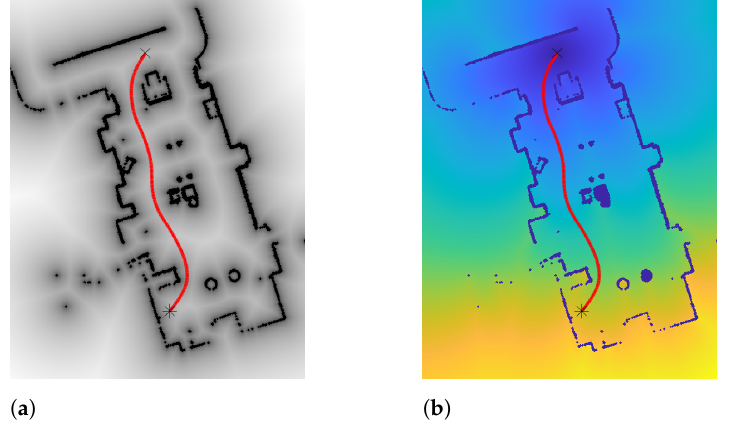
Figure 3. Example of FM2 implementation. ( a ) Velocity map saturated at a value of 0.6. ( b ) Repre- sentation of the arrival times T ( ρ ) in the second FMM stage. The final trajectory is represented on both